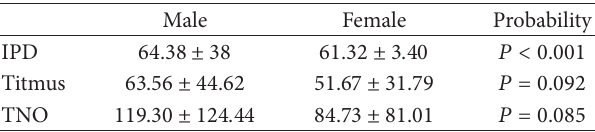
Table 4: Interpupillary distance and stereopsis scores of each